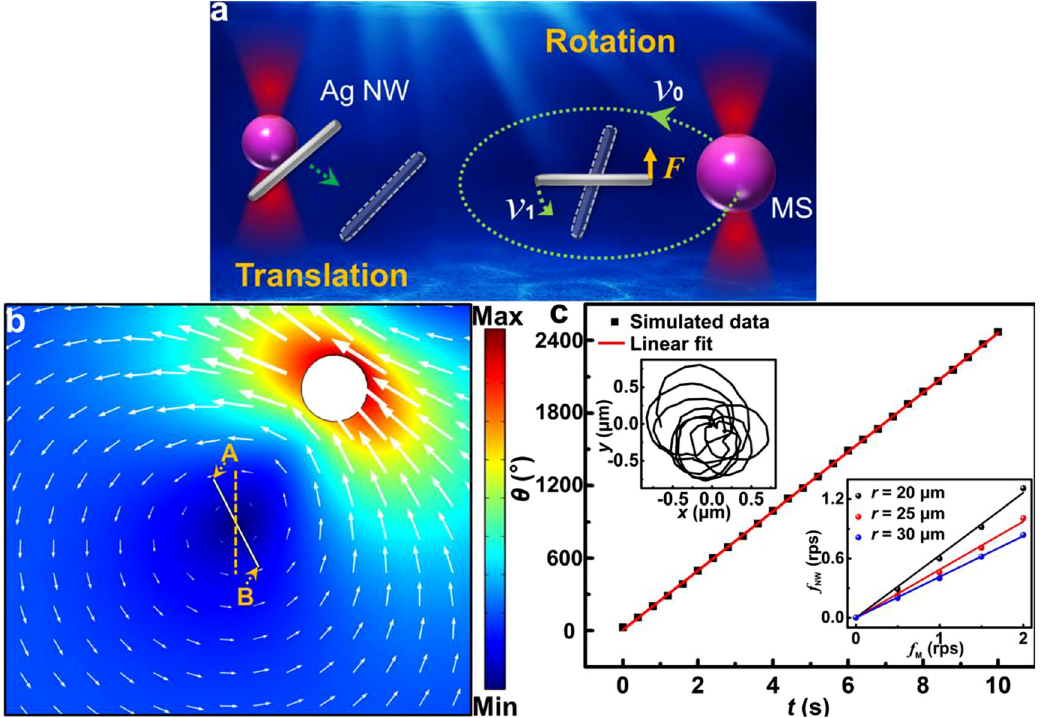
Figure 1: (a) Schematic diagram for the microsphere-assisted manipulation of a single Ag nanowire. MS and NW represent the SiO 2 micro- sphere and the Ag nanowire, respectively. (b) Simulated water fl ows distribution around Ag nanowire at t = 0.1 s. The white arrows represent the velocity of the water fl ow. (c) The rotation angle of the nanowire at different times. The inset in the upper left shows the trajectory of the midpoint of the nanowire during 10 s. The inset in the lower right shows the rotation speed of the nanowire ( f NW ) at different revolution speed ( f M ) and orbit radius ( r ) of the